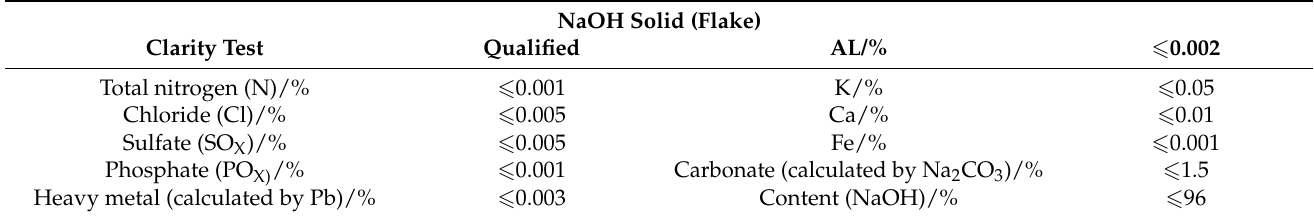
Table 4. Properties of NaOH.